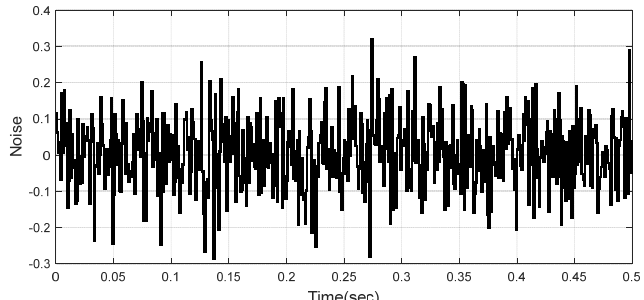
Figure 19. Measurement noise.